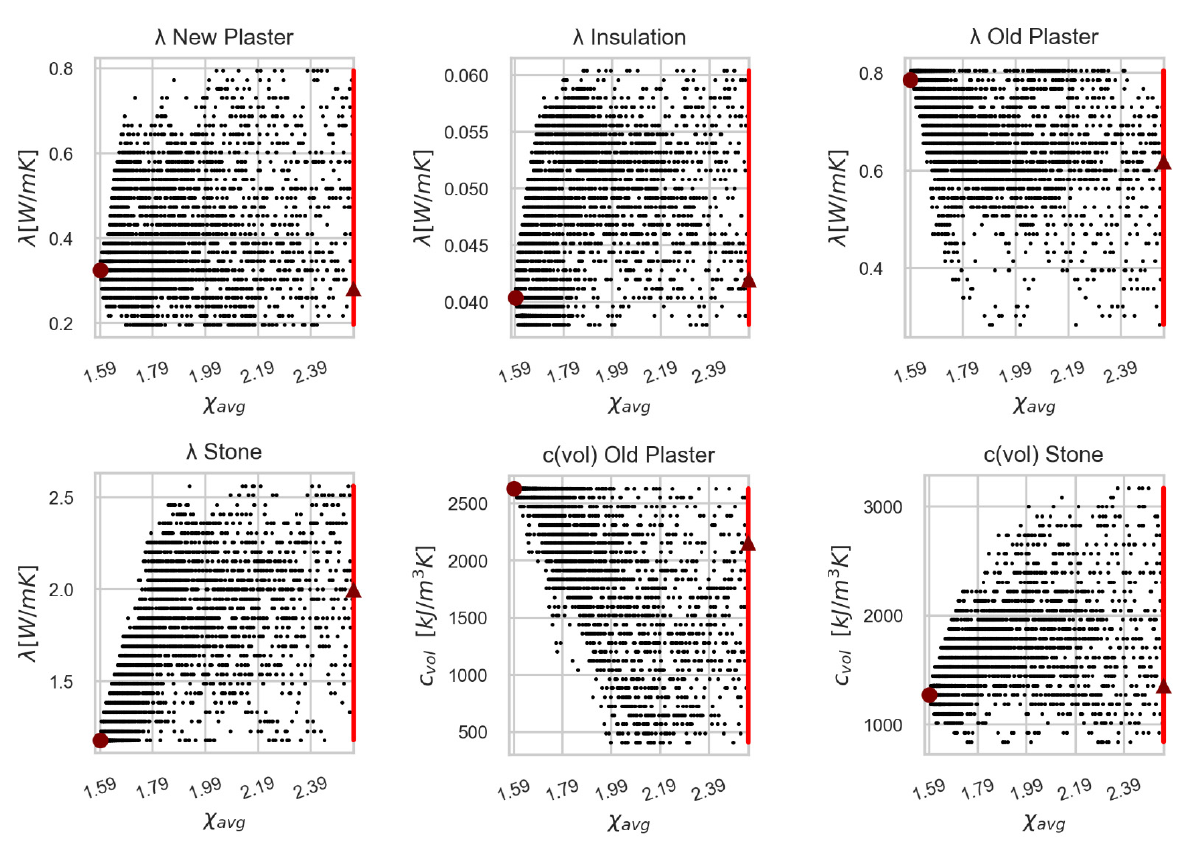
Figure 11. Overview of the second optimization results conducted on new plaster, old plaster, and stone masonry, in terms of thermal conductivity ( λ ) and volumetric heat capacity c vol .